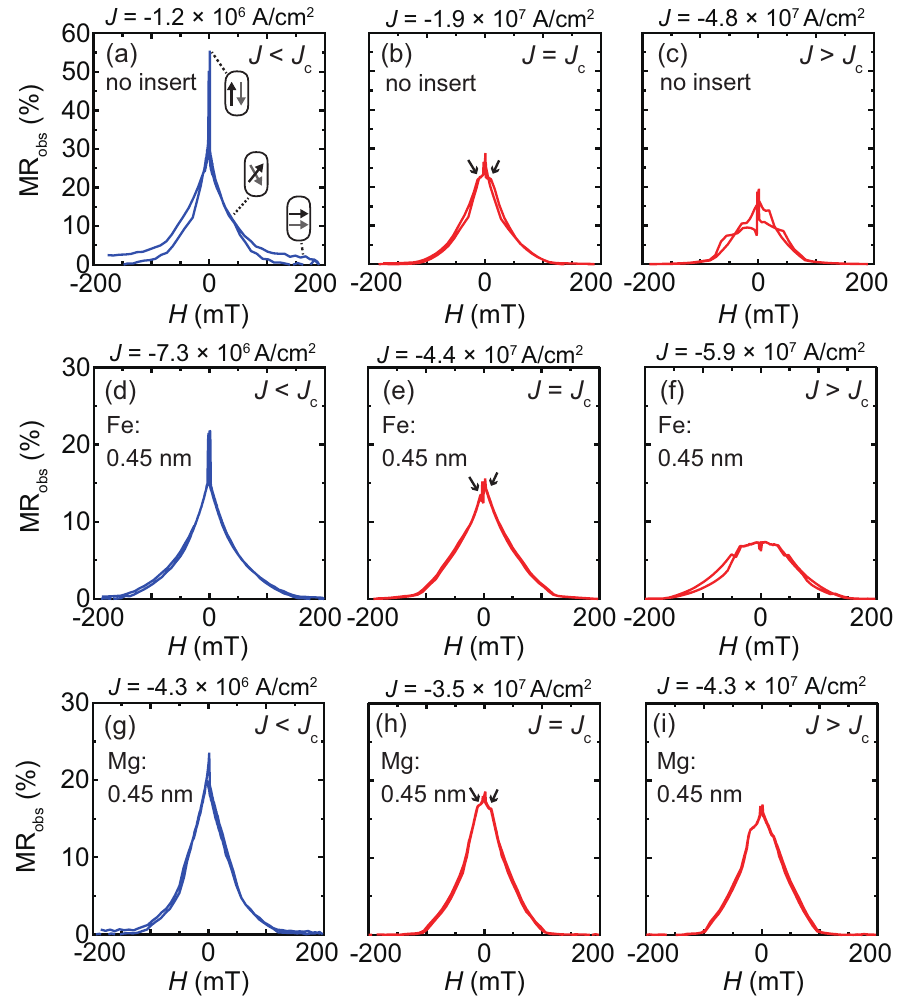
Figure 4. Bias current density, J dependence of MR curves. Junctions with ( a – c ) no insert; ( d – f ) Fe inserts, and ( g – i ) Mg inserts. The thickness of the inserts is 0.45